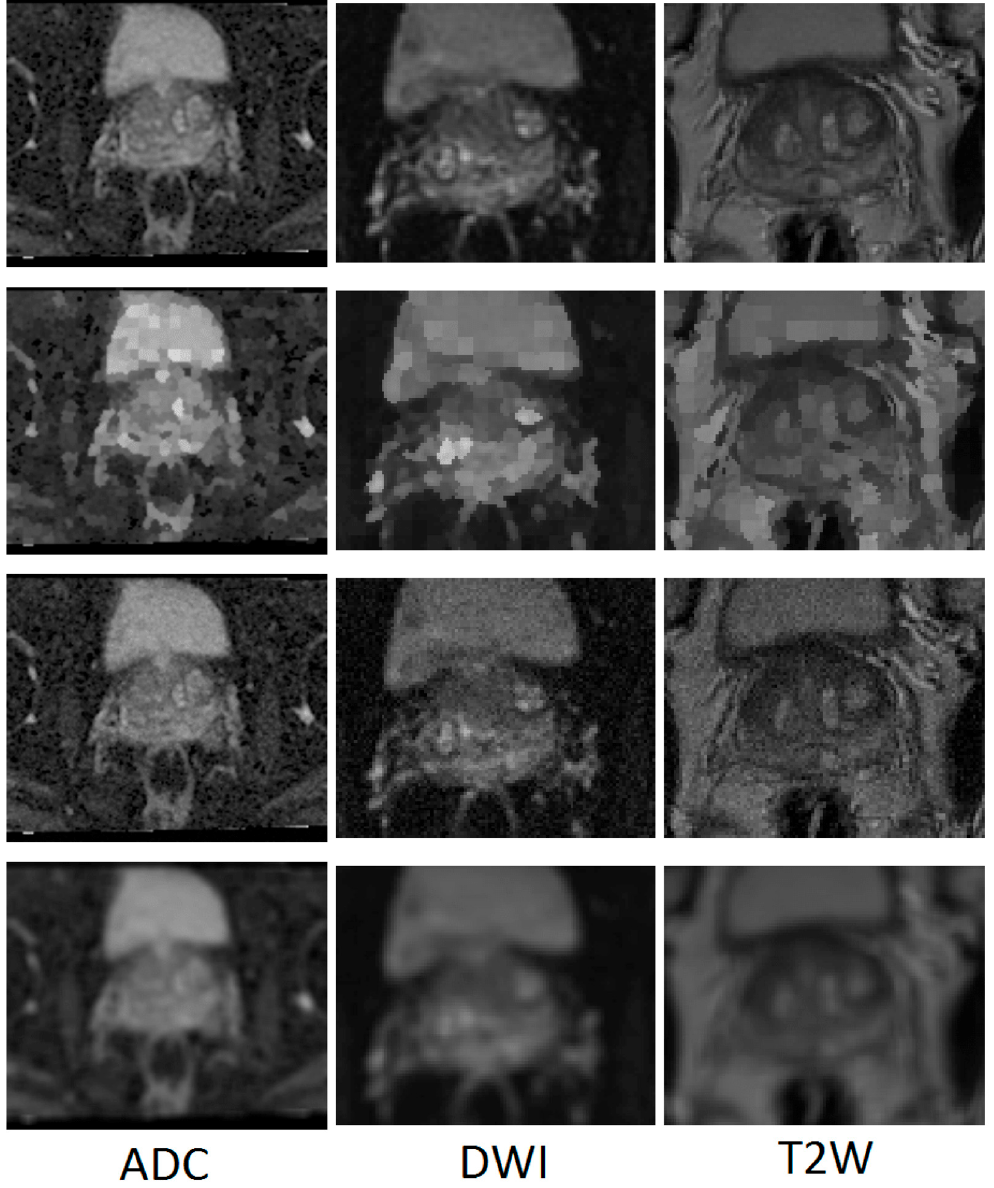
Figure 1. Examples of generated images for training. From top to bottom: raw image, super-pixel image, noise affected image and moving mean